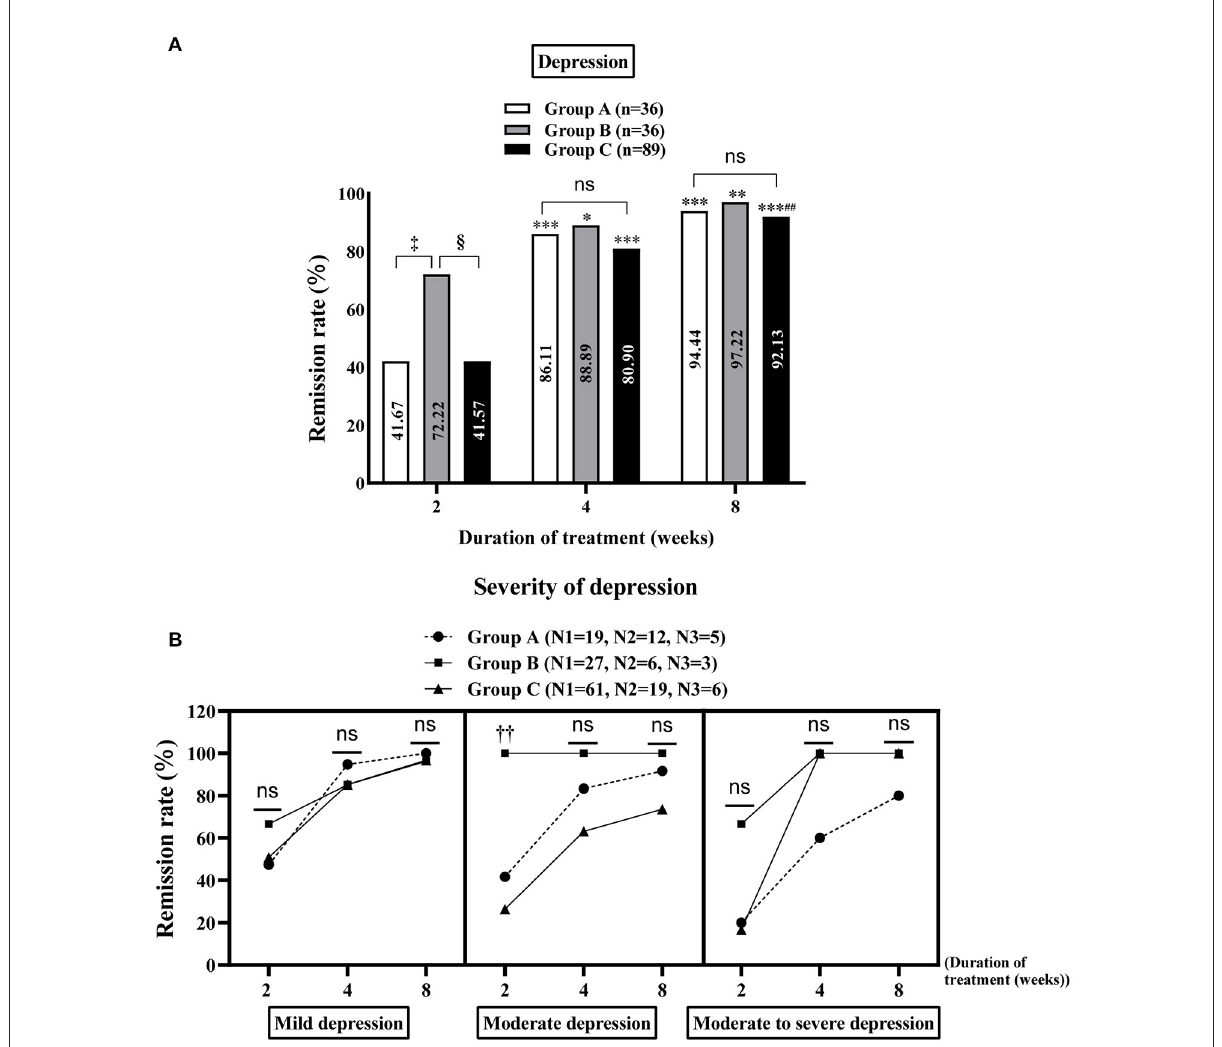
FIGURE3 Improvement of depression in the study population. Comparison of the remission rates of general depression (A) and different degrees of depression (B) in groups A, B and C at 2, 4 and 8 weeks of treatment. Group A: flupentixol and melitracen + nizatidine; Group B: flupentixol and melitracen + rabeprazole; Group C: flupentixol and melitracen. N1, N2 and N3 correspond to the number of patients with mild, moderate and moderate/severe depression, respectively. * P < 0.05, ** P < 0.01, *** P < 0.001: vs. 2 weeks of treatment in the same group. ## P < 0.01: vs. 4 weeks of treatment in the same group; ‡ P < 0.05: vs. group A at 2 weeks of treatment, § P < 0.05: vs. group C at 2 weeks of treatment. †† P < 0.05: group B [100% (6/6)] vs. group C [26.32% (5/19)] in treating moderate depression at week 2. Ns: no significance between groups A, B and C.